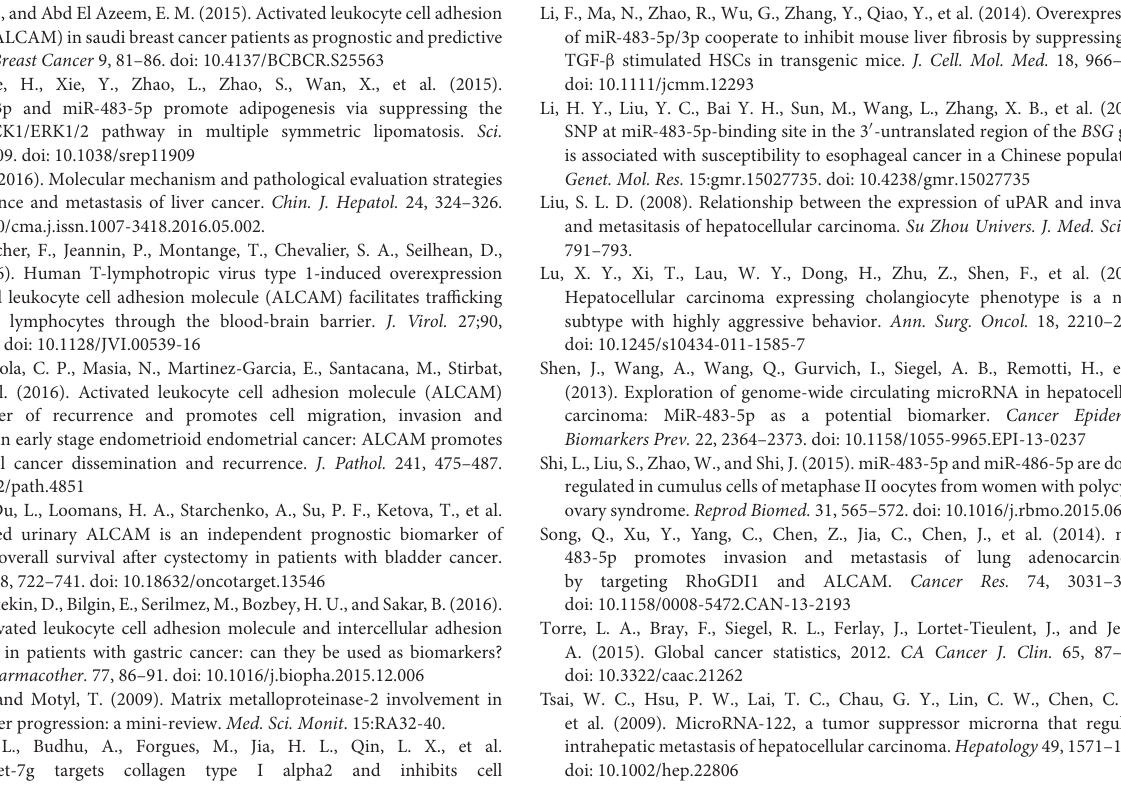
Figure S1 | Effect of miR-483-5p and ALCAM on HCC cell proliferation. (A) miR-483-5p mimics had no obvious effects on cell proliferation of SK-Hep1. (B) miR-483-5p mimics had no obvious effects on cell proliferation of SMMC-7721. (C) Knockdown of ALCAM had no obvious effects on cell